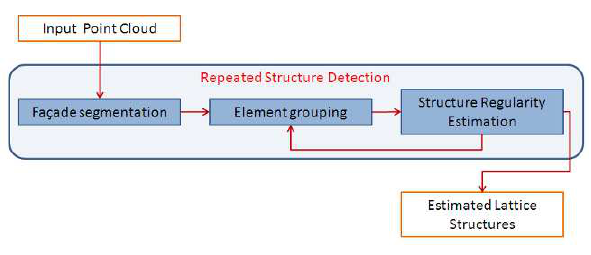
Figure 1. Workflow of the presented RSD iterative